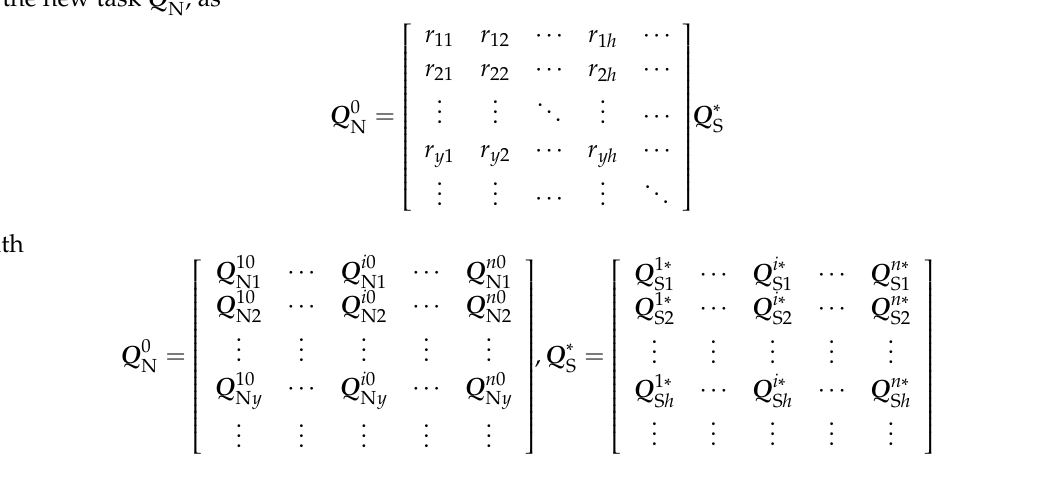
Figure 3. Behavior transfer of the TBO.